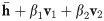
Head variants along the two principal components with the largest eigenvalues.We visualize h¯+β1v1+β2v2, where βi = bi ⋅ σi, i = 1, 2, is the weight containing the standard deviation σi to the corresponding eigenvector vi, and the factor bi ∈ {−2, 0, 2}.